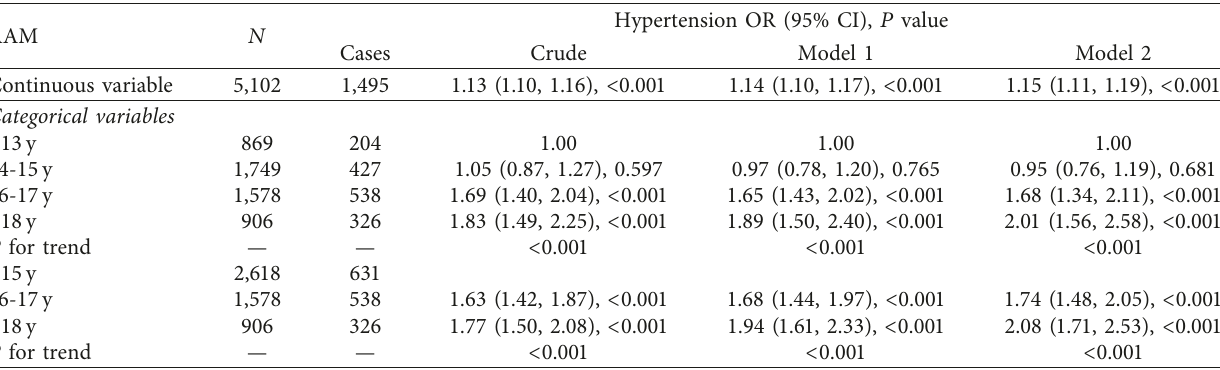
Table 2: Analysis of AAM and